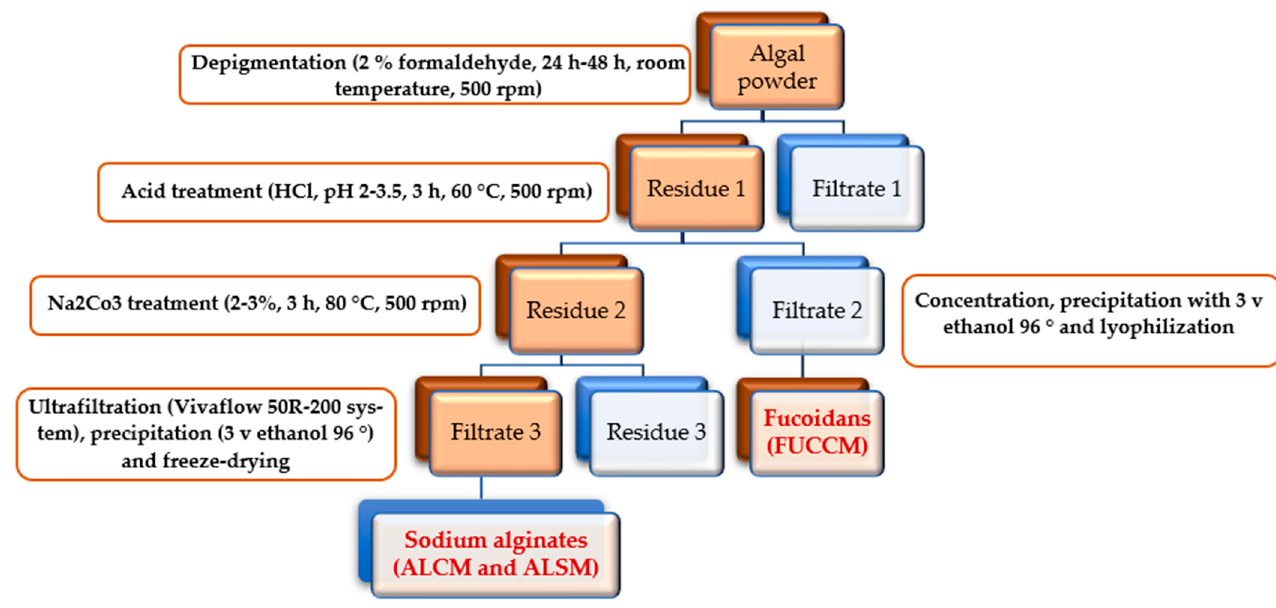
Figure 1. Extraction and purification of sodium alginates (ALCM and ALSM) and fucoidans (FUCCM) from the brown algae S. muticum (SM) and C. myriophylloides (CM). The LMW alginates OACM and OASM were obtained from ALCM and ALSM, re- spectively. The radical hydrolysis was performed using hydrogen peroxide (H 2 O 2 ) [26]. Briefly, alginates were dissolved in distilled water at a concentration of 10 g/L and shaken for 1–2 h at 70 °C. H 2 O 2 was added to the solution in a 1:1 ( w / w ) ratio, and the mixture was incubated for 6 h (70 °C, 300 rpm). The reaction was stopped by adding 96° (1/10, v / v ) ethanol and stirring for 1 h at room temperature to remove the residual H 2 O 2 . The samples were lyophilized, dissolved in distilled water, and washed several times with ethanol (96°). At the end of the experiment, the H 2 O 2 was quantified to ensure its elimination. The oxidative fractions were finally re-dissolved in distilled water and freeze-dried for 72 h. The sulfated arabinogalactan-rich-protein, crude, and purified fractions (AGB and AGP) were extracted from the green seaweed (CD). As described in the previous study